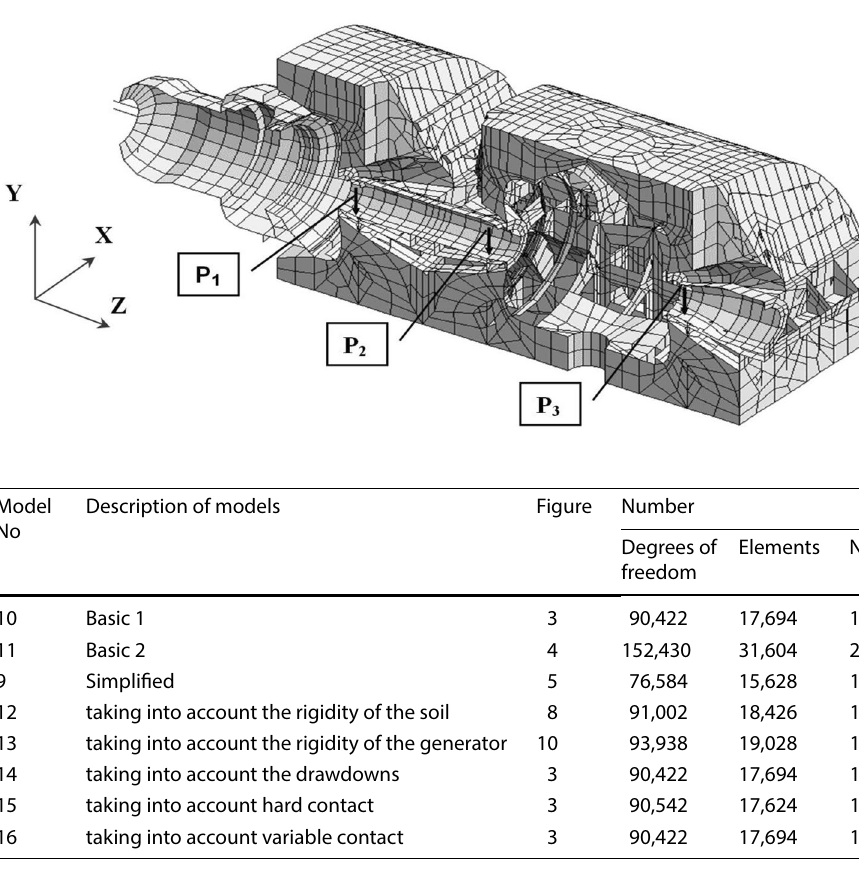
Fig. 5 Computational simpli- fied model 9 with a low degree of sampling